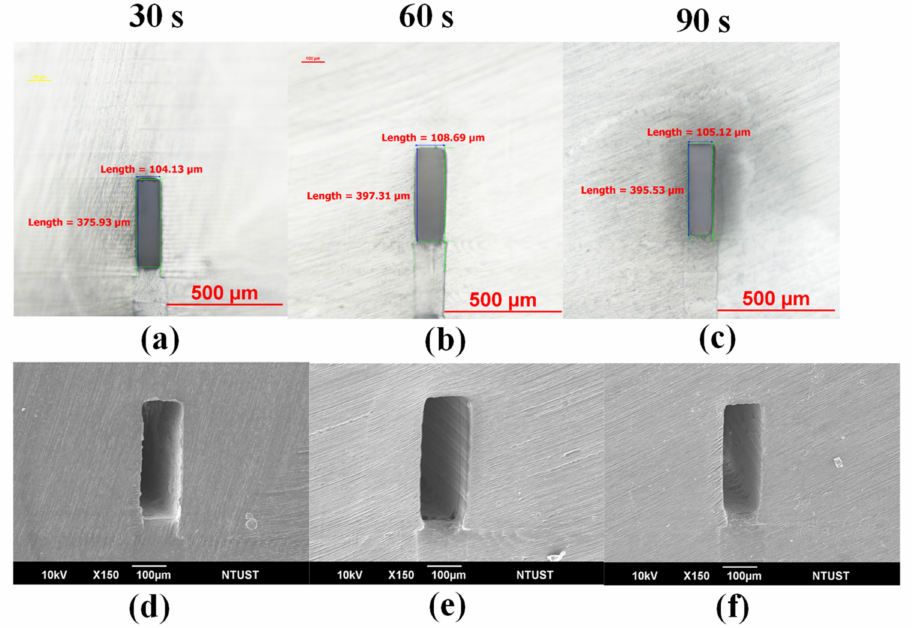
Figure 5. ( a – c ) Cross-sections with measurements obtained using a tool microscope; ( d – f ) SEM cross-sections corresponding to dwell times of 30, 60, and 90 s,